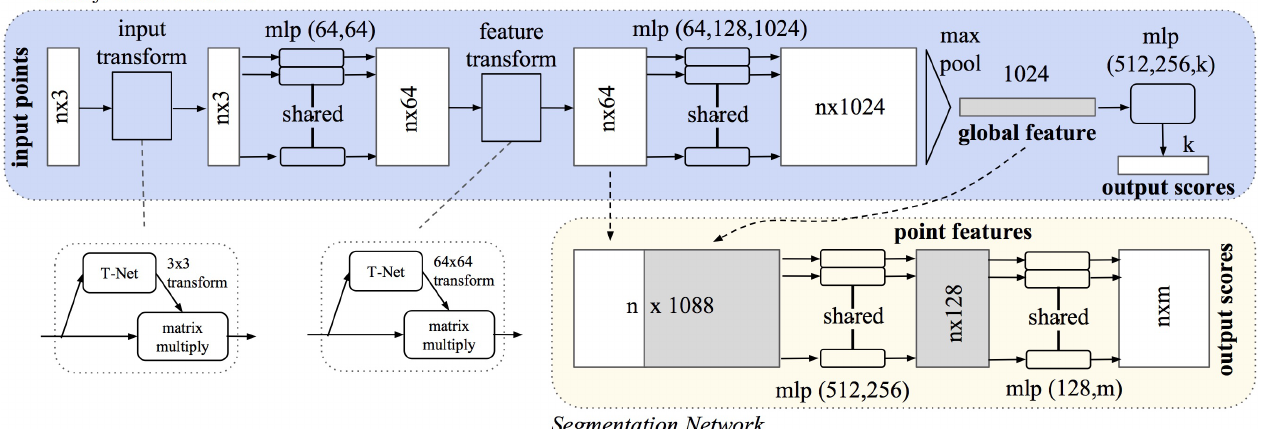
Figure 4. The principle of PointNet. Point positions are transformed into spatial features by two stages of MLPs, before they are pooled into a global feature vector describing the whole object. Afterwards, a combination of local and global features can be used for segmentation purposes